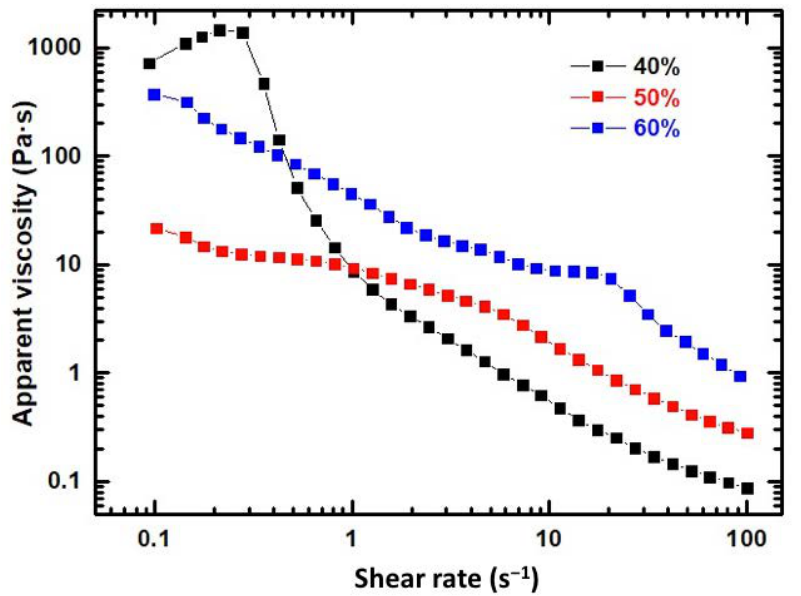
Figure 1. Apparent viscosity of SG40TCPy (y = 40, 50 and 60 wt% β -TCP) pastes vs shear rate. By this way, 3D scaffolds with dimensions of 10 × 10 × 5 mm 3 named as SG40TCP60- RC were obtained by the deposition of perpendicular layers of parallel rods with a 610.0 ± 18.0-micrometer diameter in a paraffin bath to reduce non-uniform drying through- out the printing